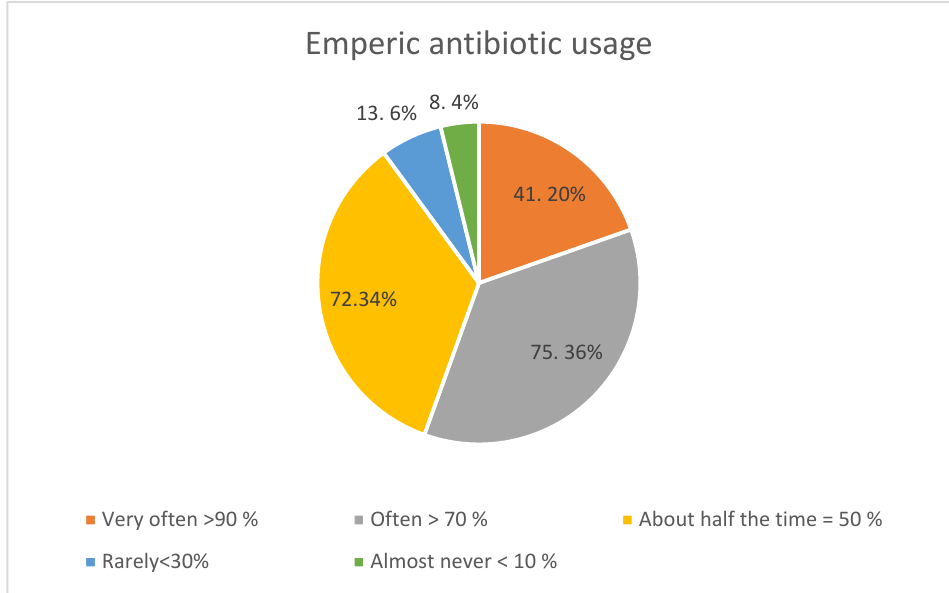
Figure 1. Proportion of respondents prescribing antibiotics empirically.